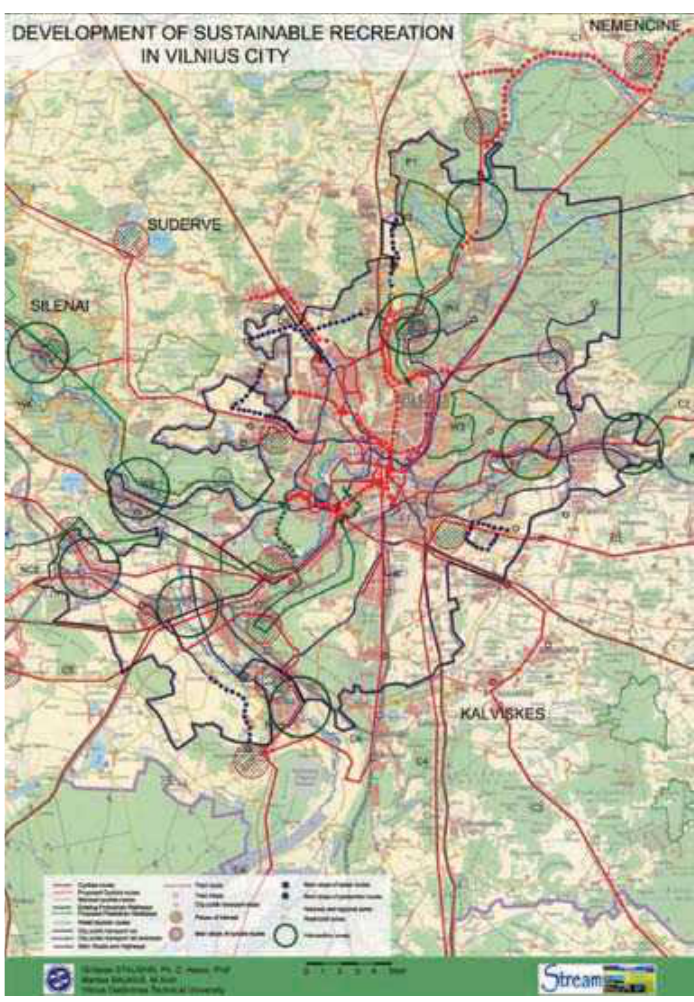
Fig. 4. Planning proposals for the network of sustainable recreation and tourism tracks in Vilnius